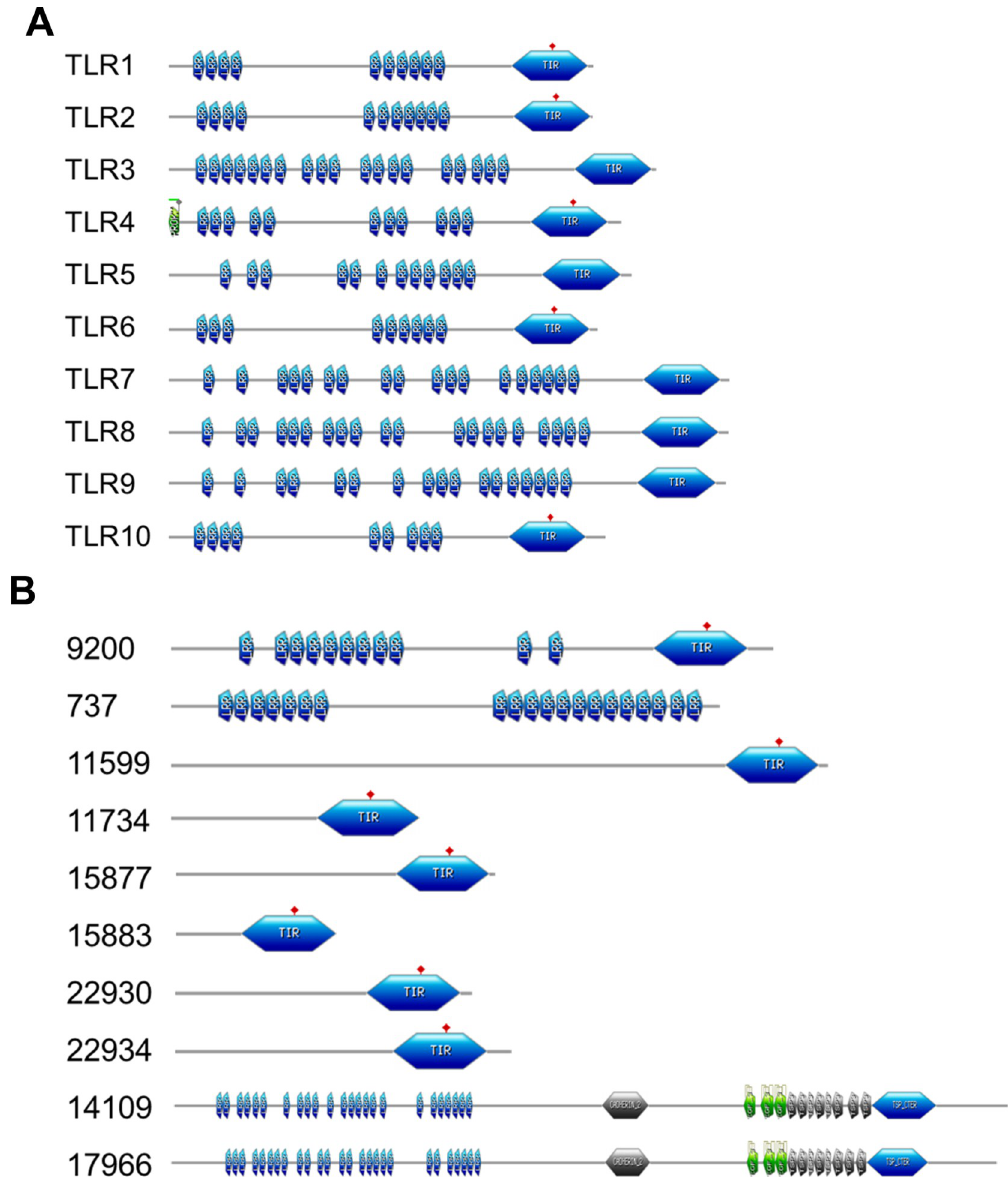
Fig 7. PROSITE analysis of human and coral TLRs. (A) PROSITE domain mapping of human TLRs. (B) PROSITE domain mapping of possible P . damicornis TLR